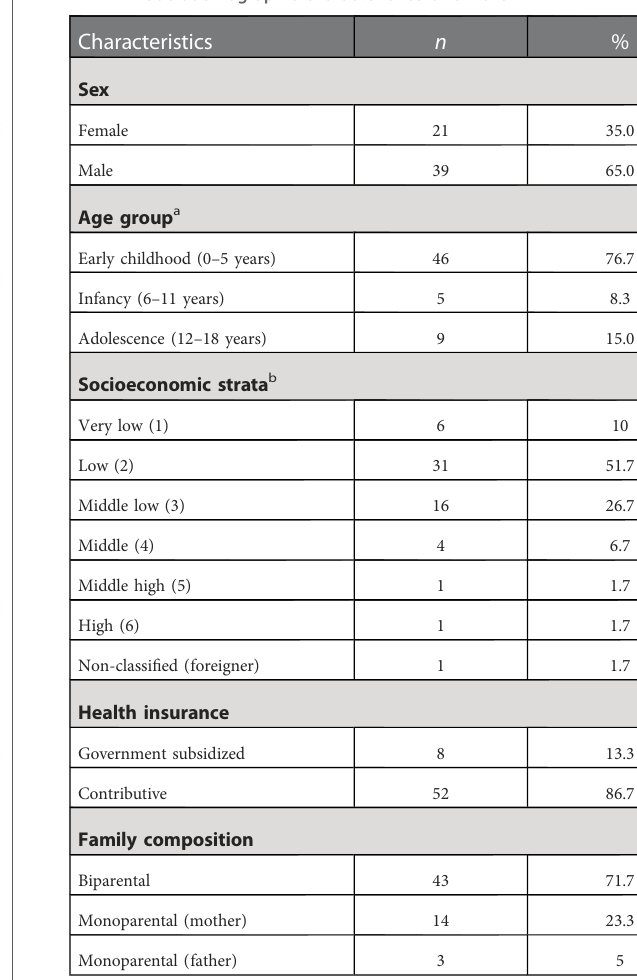
TABLE 1 Sociodemographic characteristics of